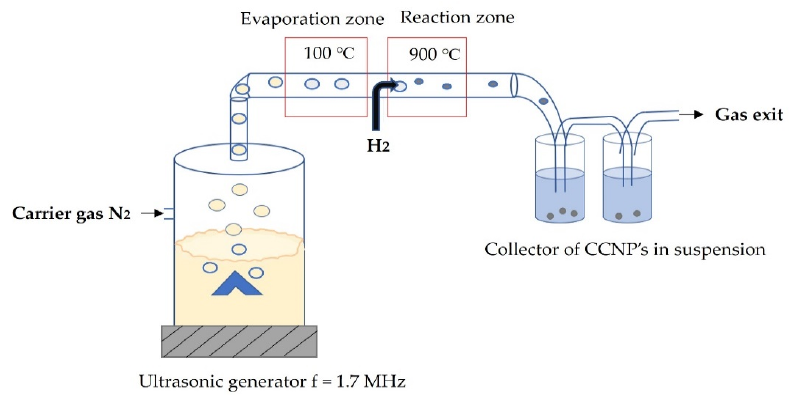
Figure 3. Schematic representation of CCNPs’ synthesis via USP.